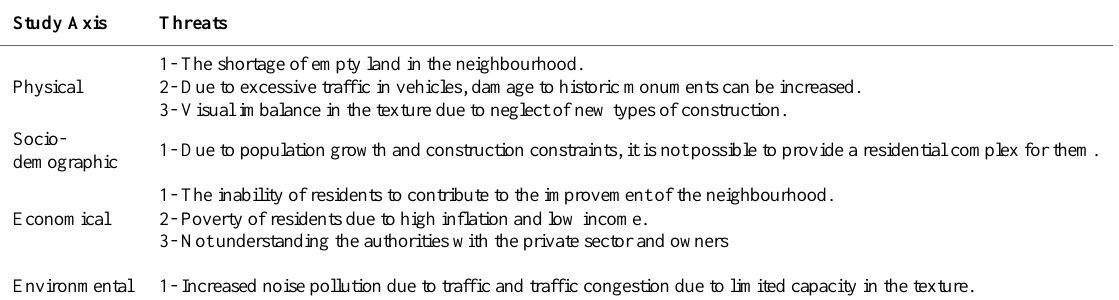
Table 4. Analysis of the Threats of the Neighbourhoods using the SWOT technique Study